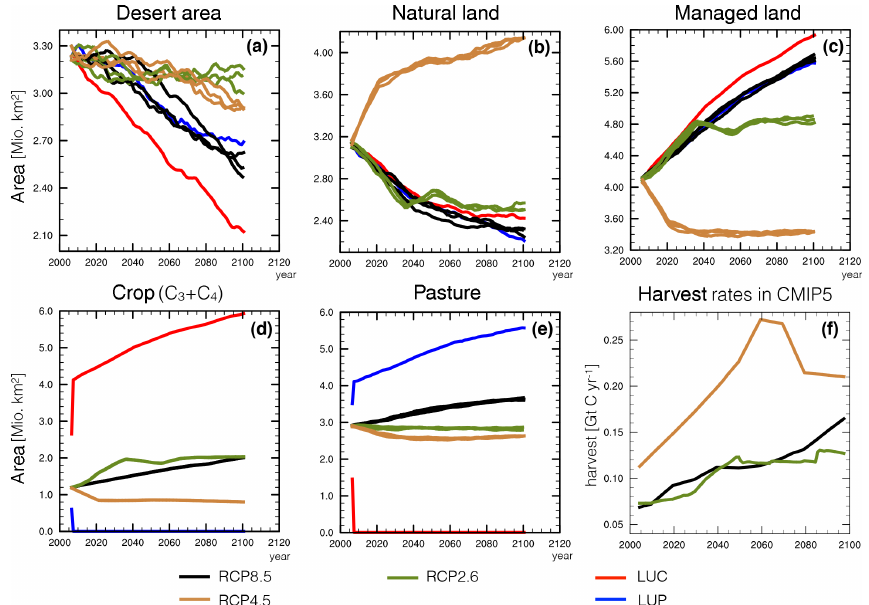
Figure 4. Top row: temporal course of the simulated desert area (a) , natural land (b) , and managed (c) land within three different CMIP5 scenarios and two land use scenarios (LUC, LUP) within the next century (2006 to 2100). Bottom row: changes of anthropogenic land use within the next century is given for crops (d) and pasture (e) separately. Values are given in millions of square kilometres. The different harvest rates within the CMIP5 scenarios are shown in (f) . Shown are integrated values only for our area of interest, where the strong land use experiments take place. The dashed and dotted black lines represent the three ensemble members of the RCP8.5 scenario, while the dashed one marks the ensemble member based on the same restart (year 2005) as the land use experiments for this study.